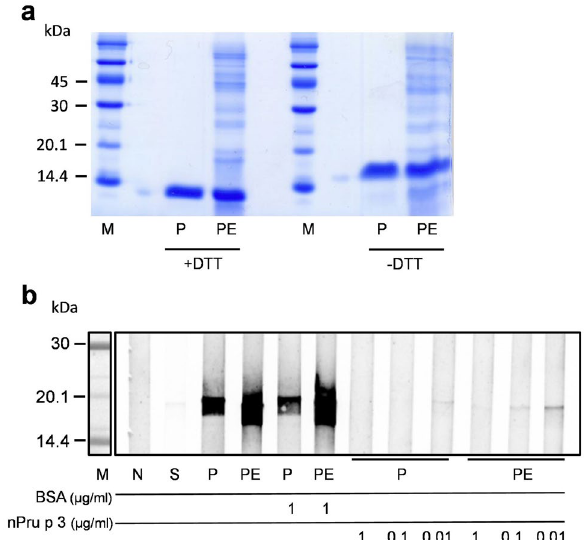
Figure 1. Characteristics of peach peel extract (PE). ( a ) Protein pattern of peach peel extract (PE) was determined via SDS-PAGE and Coomassie staining, natural Pru p 3 (nPru p 3; P) was used as reference; ( b ) nPru p 3 or PE were subjected to SDS-PAGE followed by immunoblot analysis. To determine allergen reactivity, nsLTP-reactive rabbit serum was used and inhibition of antibody binding was performed with increasing dosages of nPru p 3 or BSA as control. Negative control (N) or secondary antibody control (S) were incubated with either buffer or only secondary